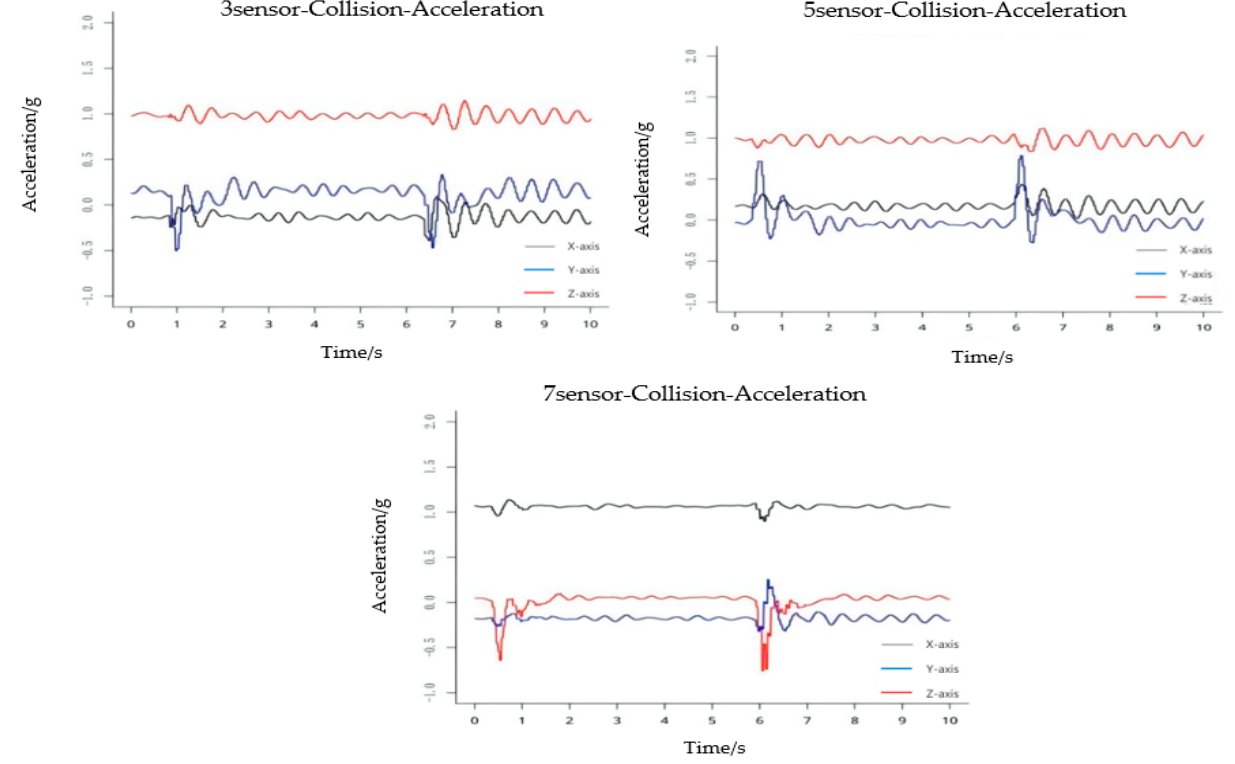
Figure 4. Acceleration graph during a collision.